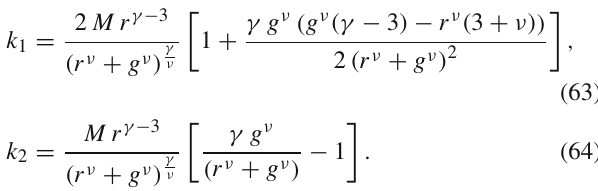
± rtf ) and angular 0